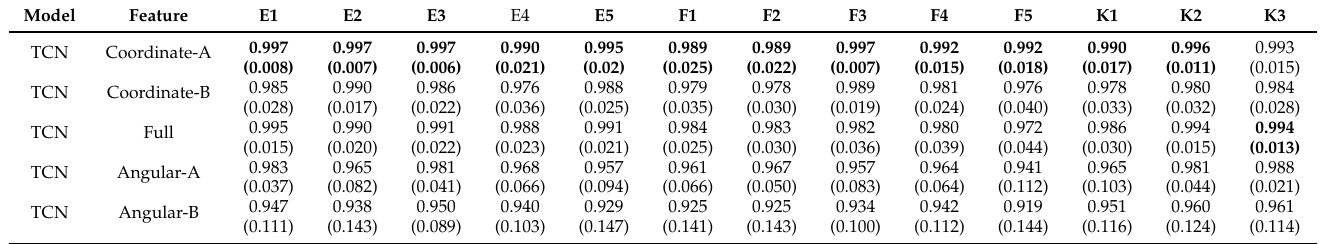
Table 13. Average AUROC result obtained by the TCN model. Numbers in parentheses denote standard deviation and the text in bold denotes the best performance for each drawing pattern. E, F, and K denote English, freestyle, and Korean patterns, respectively.